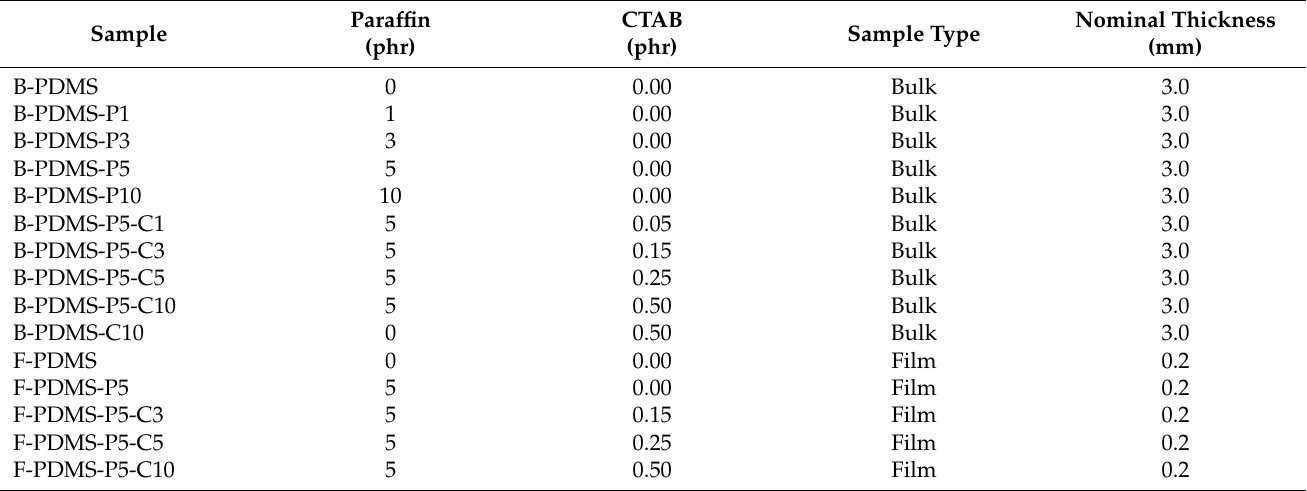
Table 1. List of prepared samples with nominal composition and processing. The weight fractions of paraffin and CTAB are expressed in phr over the total amount of PDMS (A +